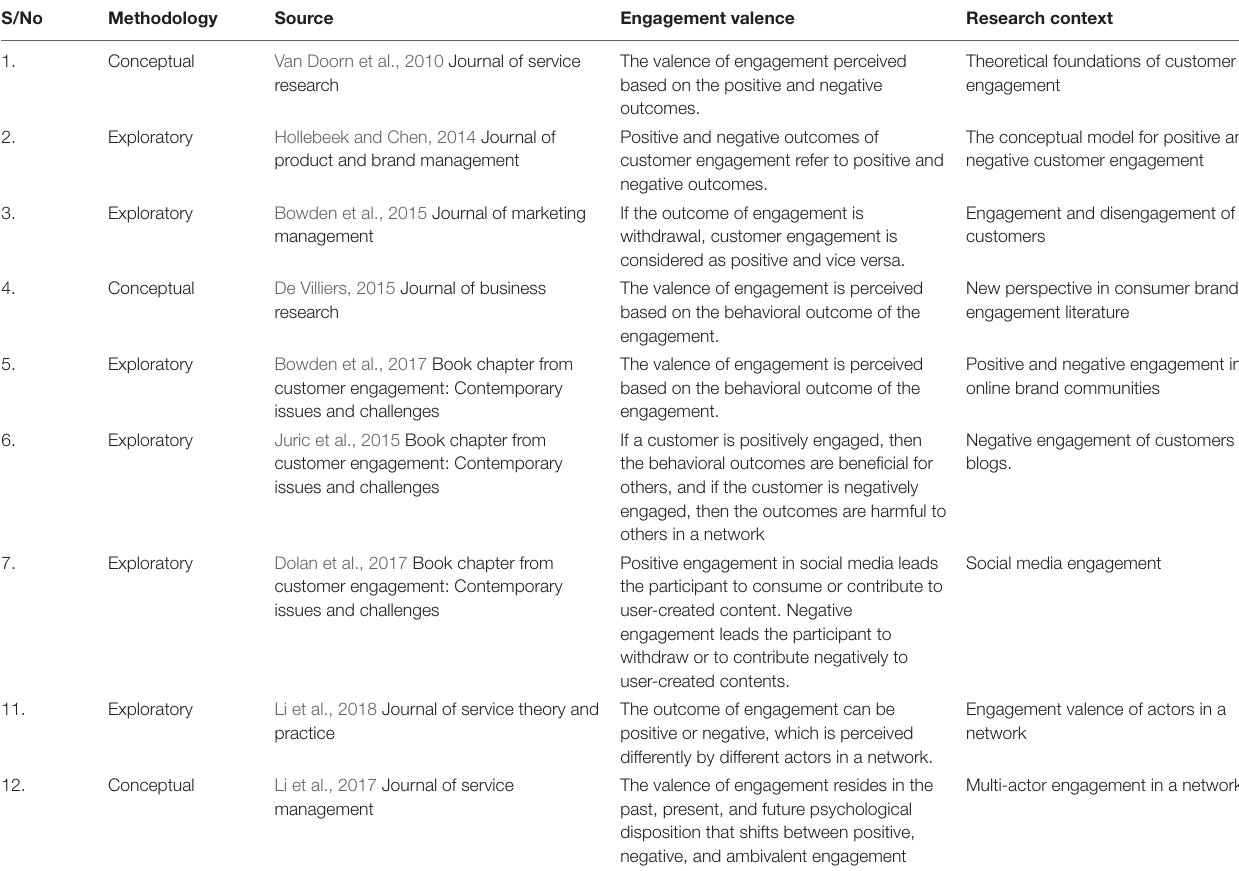
TABLE 1 | Past literature on engagement valence.